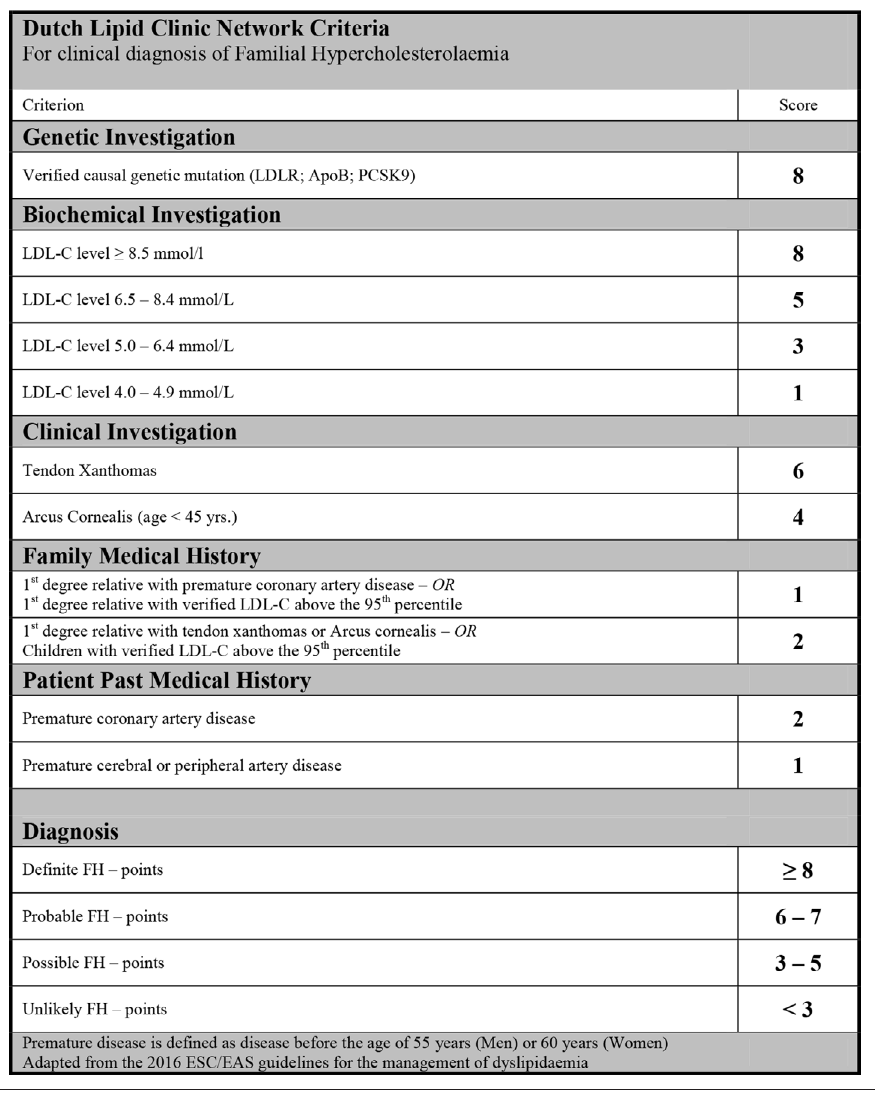
lipoprotein receptor. PCSK9 = proprotein convertase subtilisin/kexin type